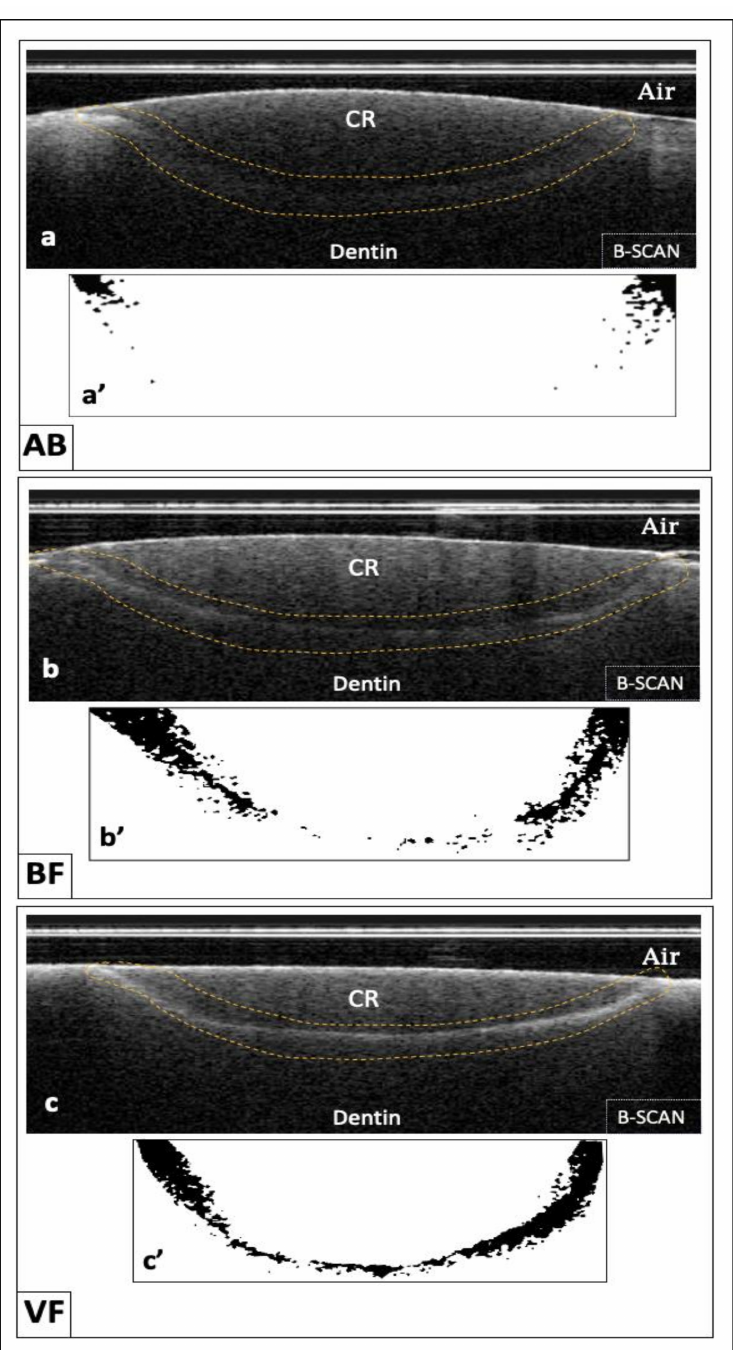
Figure 2. Representative B-scan images of the tested groups. (AB): In ( a ), the cavity floor in the AB group demonstrated slightly low signal intensity (dotted frame) without bright white cluster formation. After applying binarization function to the cavity floor (dotted frame in ( a )), ( a’ ) did not detect any changes in the background in the form of black pixels formation that represent gaps except for the cavity margins. (BF): In ( b ), the cavity floor in the BF group showed heavier signal intensity than the AB group (dotted frame) with some scattered bright white clusters formation. These clusters became scattered dark pixels on a white background in ( b’ ). (VF): In ( c ), the cavity floor in the (VF) group showed the highest signal intensity among all the tested groups [dotted frame in ( c )] with heavier clusters formation. After binarization, which facilitated gap quantification, ( c’ ) black pixels were observed on the white background, and this was interpreted as gap